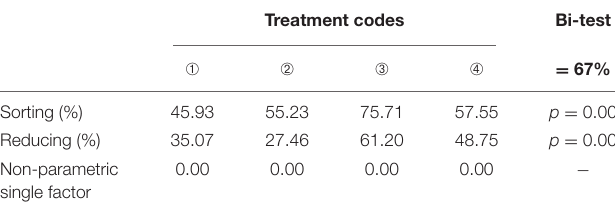
TABLE 5 | Pro-environmental behaviors (PEBs) and framework